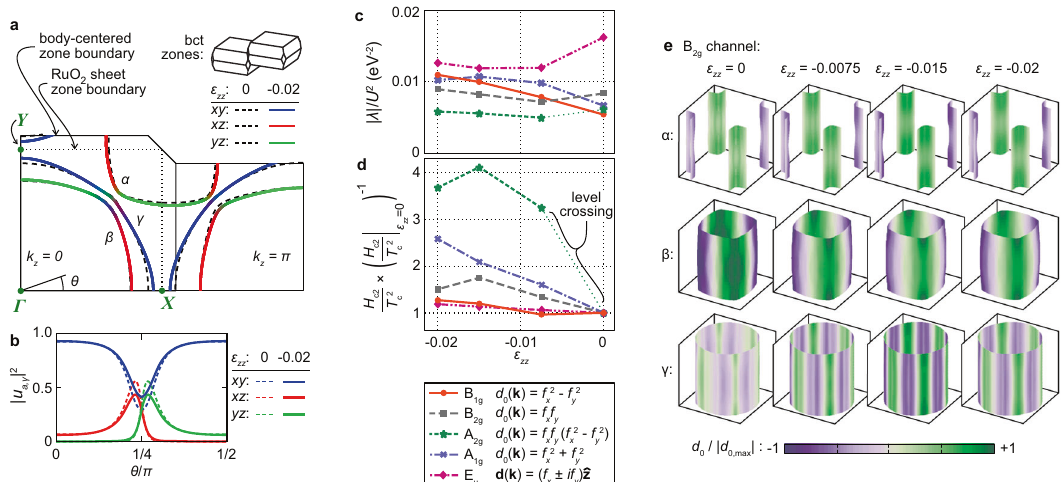
Fig. 5 | Weak-coupling calculations of Sr 2 RuO 4 under c-axis strain. a Cuts through the tight-binding Fermi surfaces employed in our weak-coupling cal- culations, at ε zz =0 and − 0.02. The surfaces at ε zz = − 0.02are colored by orbital content.The solid lines show the Brillouin zone boundaries of the body-centred tetragonal unit cell of Sr 2 RuO 4 , and the dotted line of the 2D zone of the RuO 2 sheets. b Orbital weights on the γ sheet at k z =0 in this model. c Leading eigenvalues as a function of ε zz for J / U =0.15, and d H c2 ð T ! 0 Þ = T 2 c , normalised